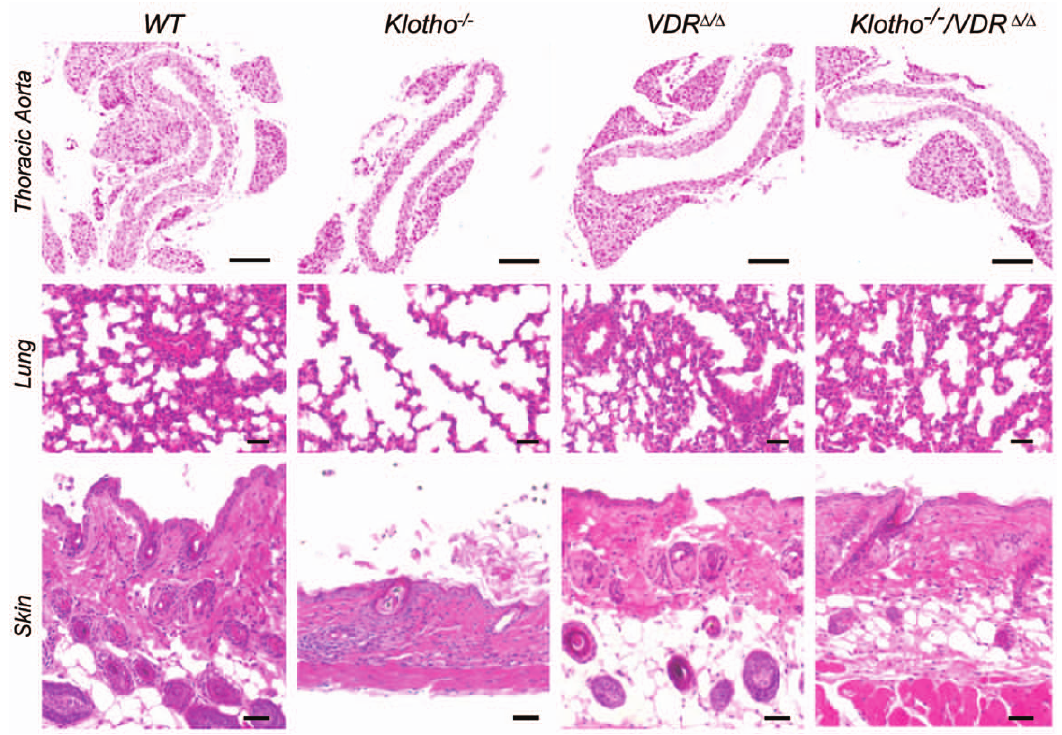
Figure 2. Ablation of VDR signaling rescues skin atrophy and pulmonary emphysema in Klotho 2 / 2 mice. Upper panel shows representative von Kossa-stained sections counterstained with nuclear fast red of thoracic aortae from 4-week-old WT , Kl 2 / 2 , VDR D / D , and Kl 2 / 2 / VDR D / D mice. No ectopic calcifications are present in Kl 2 / 2 mice but a thinning of the aortic wall is evident. Middle and lower panels show HE stained sections. Pulmonary emphysema and severe skin atrophy with almost complete lack of subcutaneous fat tissue is clearly evident in Kl 2 / 2 mice, but absent in Kl 2 / 2 /VDR D / D compound mutants. All animals were fed the rescue diet. Five- m m-thick paraffin sections. Bar=200 m m.